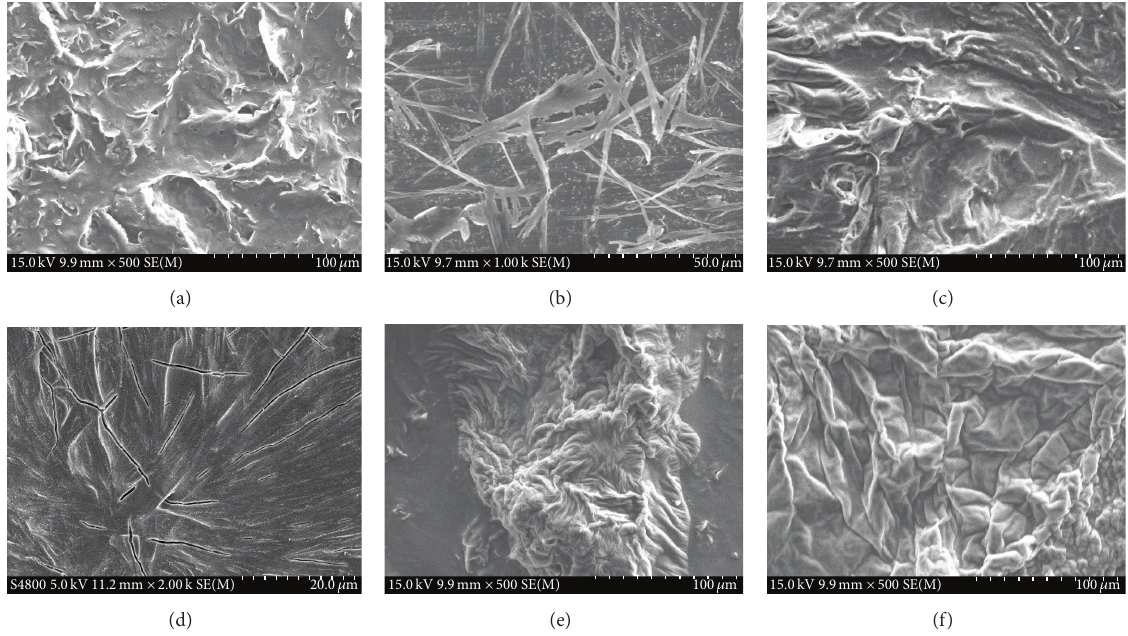
Figure 2: SEM images of xerogels: (a) and ((c)–(f)): C18-Azo, C16-Azo, C14-Azo, C18-Azo-Me, and C16-Azo-Me in ethanolamine, respectively; (b) C16-Azo in nitrobenzene.